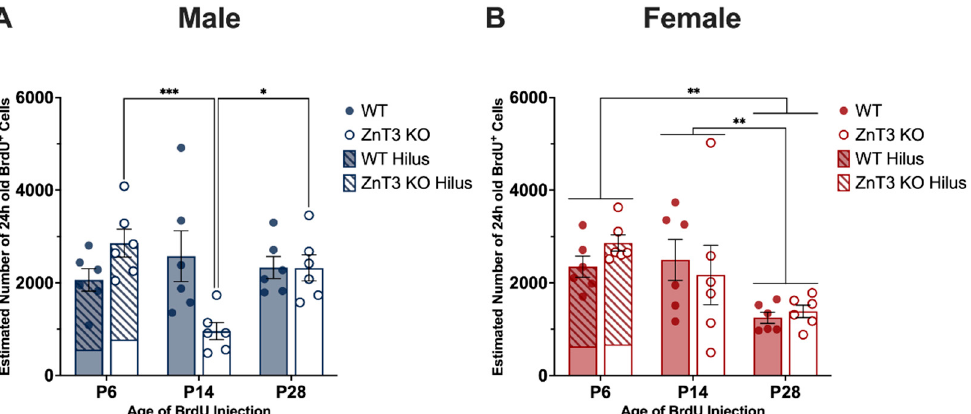
Figure 4. Age effects on cell proliferation, as measured by BrdU + cells, in male and female WT and ZnT3 KO mice injected on P6, P14, and P28. BrdU was administered to male and female WT and ZnT3 KO mice on P6, P14, or P28 to label dividing cells ( n = 6 per group). To assess cell proliferation, brains were collected approximately 24 h after the last injection, and BrdU + cells were counted in the hilus and SGZ/GCL for P6 brains (P6 bars represent the aggregate; diagonal stripes indicate counts from the hilus) and the SGZ and GCL for P14 and P28 brains. ( A ) There were no significant differences in the number of BrdU + cells between male WT mice injected on P6, P14, and P28. In contrast, male ZnT3 KO mice injected on P14 had significantly lower levels of BrdU + cells compared to mice injected on P6 and P28. ( B ) In female mice, WT and ZnT3 KO mice injected on P6 and P14 had significantly higher levels of BrdU + cells compared to mice injected on P28. Error bars represent ± standard error of the mean. * Indicates p < 0.050; ** indicates p < 0.010; *** indicates p < 0.001.